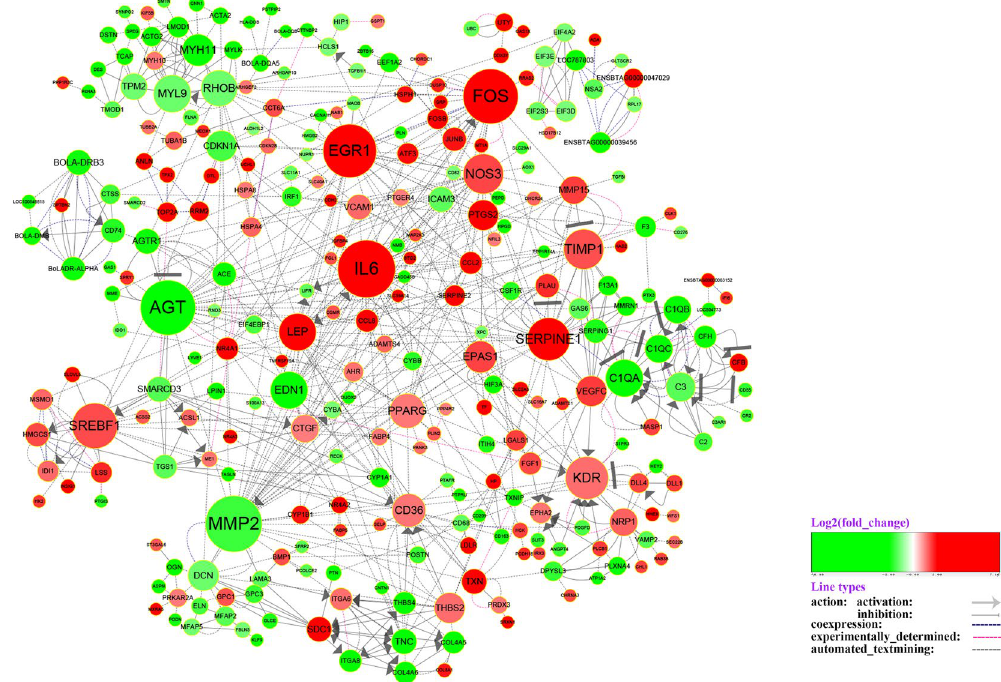
Figure 4. Protein-protein interaction network of differentially expressed genes. Node represents protein, edge represents interaction between proteins, size of the node is proportional to degree of this node (degree of the node is defined as amount of proteins that interact with this node), and color of node represents Log2FoldChange in expression levels of differentially expressed genes between Wagyu and Holstein